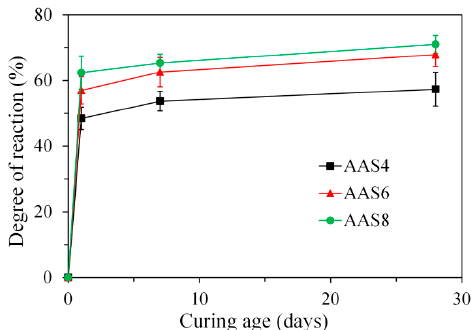
Figure 6. Degree of reaction of slag, derived from image analysis, for AAS4, AAS6, and AAS8. In the graphs, AAS indicates alkali-activated slag, and the number following AAS refers to the weight percentage of Na 2 O with respect to slag. For all samples, the water to slag ratio was 0.4 and the curing temperature was 20 °C.